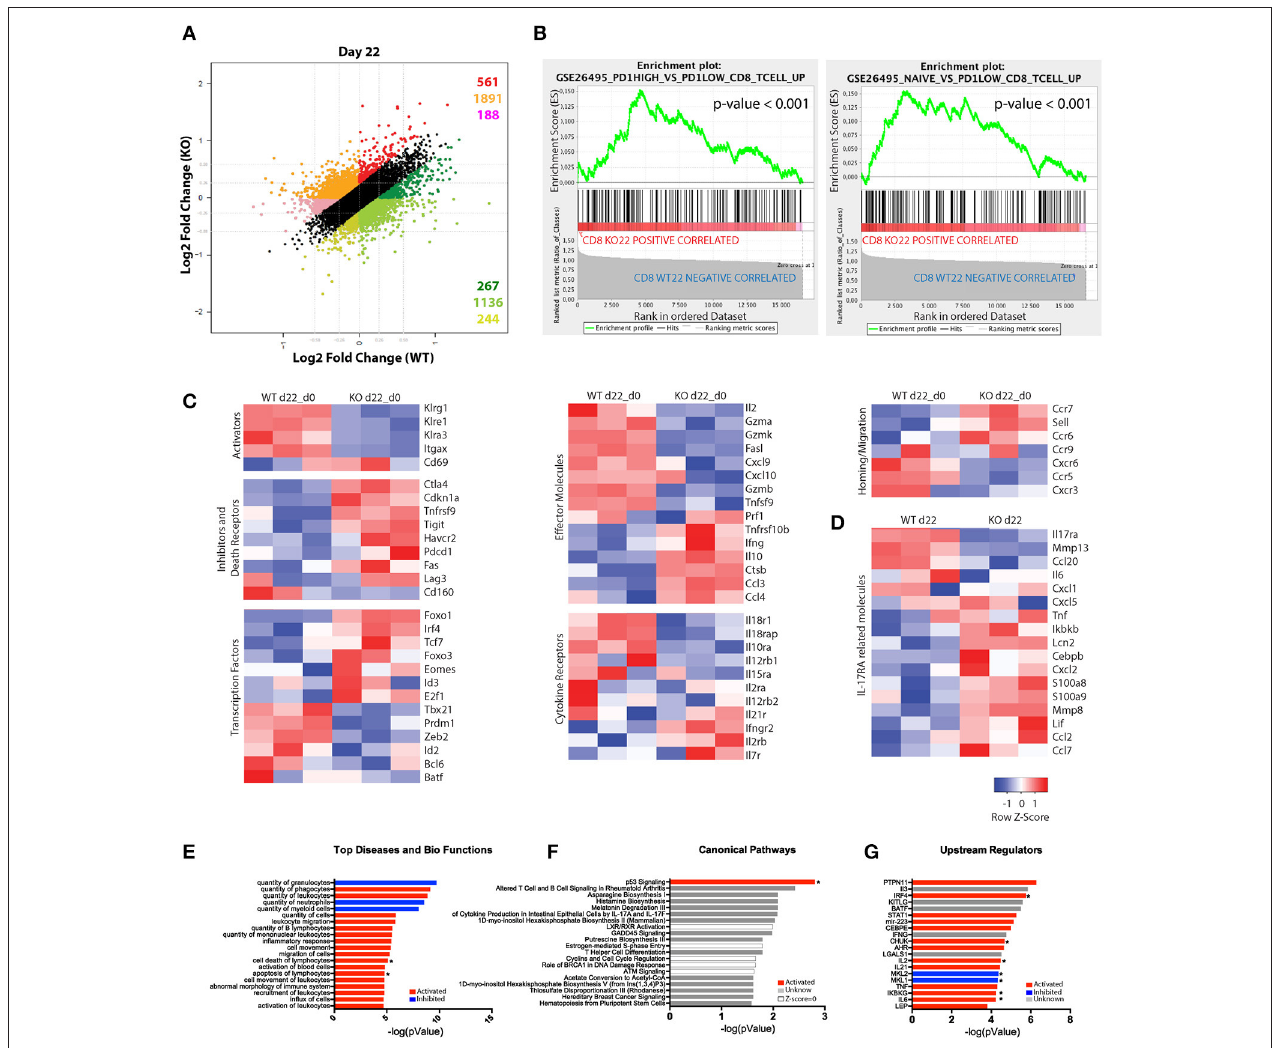
FIGURE 3 | Substantial differences in the gene-expression profile of CD8 + T cells from T. cruzi -infected IL-17RA KO and WT mice. (A–F) Microarray analysis of purified CD8 + T cells from infected WT (WT-I) and IL-17RA KO (KO-I) mice (22 dpi) and non-infected controls (WT-N and KO-N). N = 3 mice per group. (A) Dot plot displaying the number of genes that show a significant ≥ 1.2-fold difference in fold change expression of WT-I and KO-I relative to non-infected counterparts. Colors indicate sets of genes with different expression patterns. (B) Top two enrichment plots in KO-I ( p < 0.001) determined by supervised analysis of all infection induced genes in WT-I and KO-I using GSEA26495 and GSEA41867 (MSigDB C5BP) signature gene sets. (C) Heat maps of expression of selected genes according to categories relevant to CD8 + T cell biology. The gene expression values of each sample were normalized by division to the average values of the corresponding samples from non-infected counterparts. (D) Heat map of expression of genes encoding molecules associated to IL-17RA signaling. Gene expression values represent non-normalized data from 3 mice. (E–G) IPA of genes induced by the infection but showing significantly higher expression in IL-17RA KO mice (red genes in A ). Top 20 “Diseases and Bio-functions” (E) , “Canonical pathways” (F) , and “Up-stream regulators” (G) that were most significantly altered ( P < 0.05 with Fischer’s exact test) in KO mice are shown. The activation Z-score was calculated to predict activation (red), inhibition (blue), categories where no predictions can be made